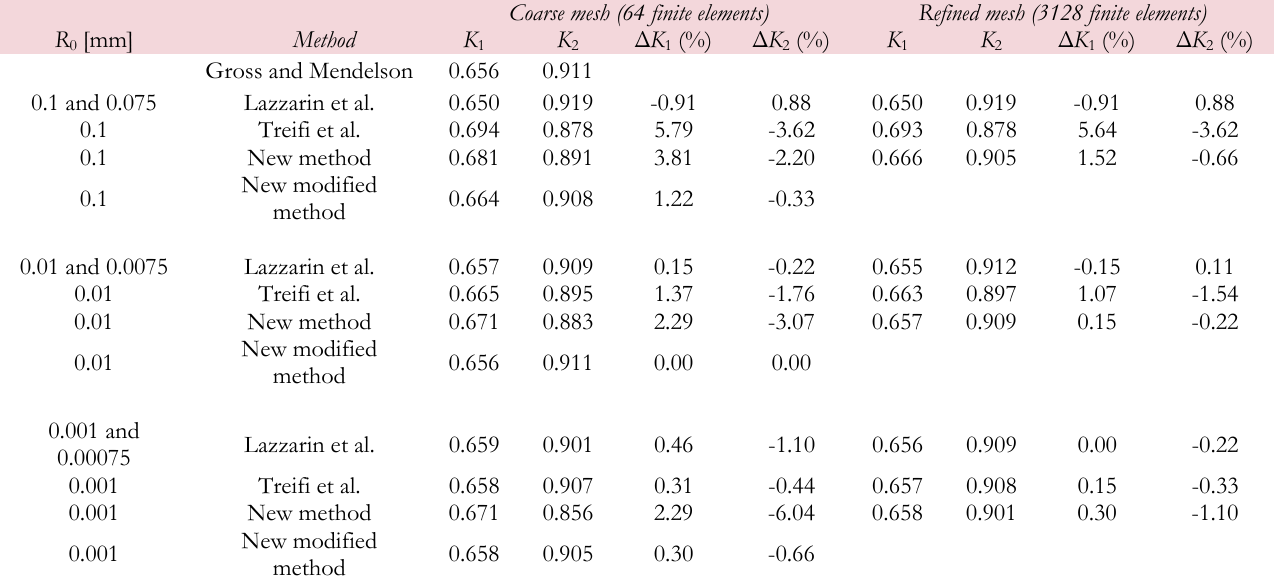
Table 1: Comparison between approximate methods for NSIFs evaluation of diamond-shaped notch (2 α = 45°).